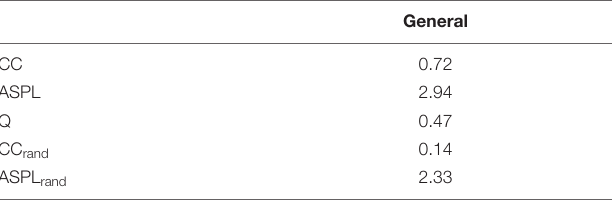
TABLE 2 | Network measures for the different